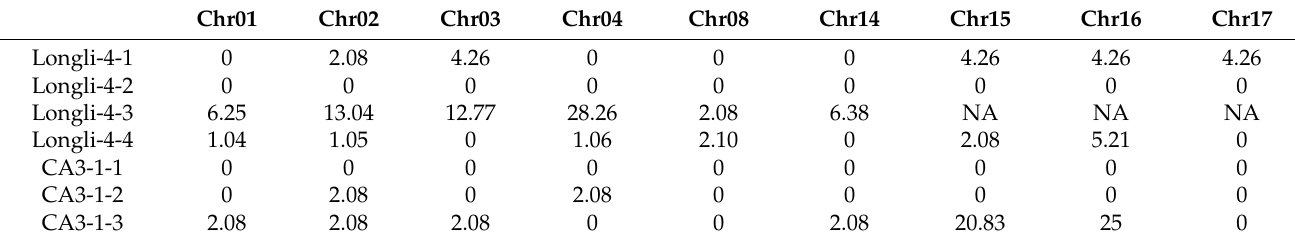
Table 2. The outcrossing rate (%) of Longli-4 and CA3-1